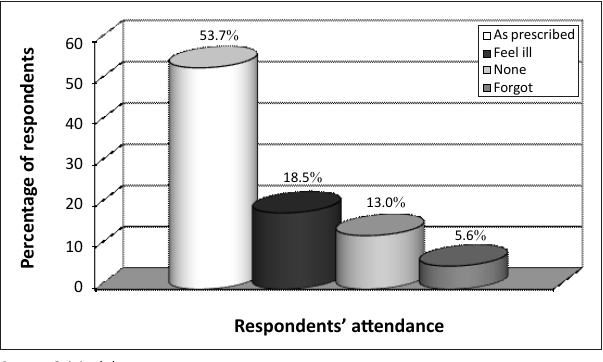
Source : Original data FIGURE 2: The percentage of respondents who took their asthma medications as prescribed, when they felt ill, not at all or when they did not forget to do so.